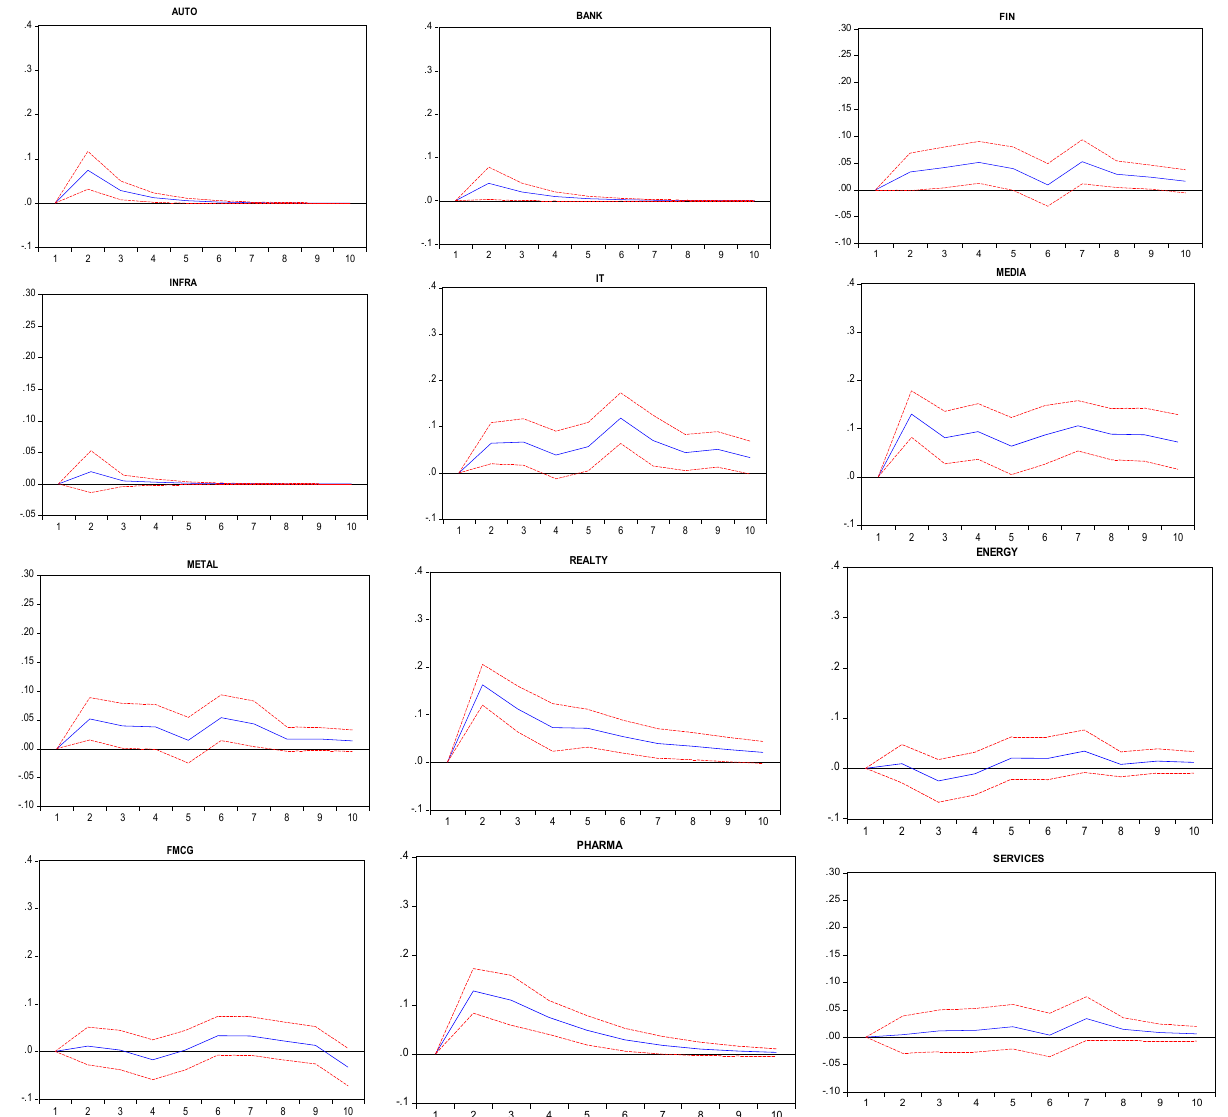
Figure 2. Response of market volume to market return shocks for the cyclical and defensive sectors (during the COVID ‐ 19 period).